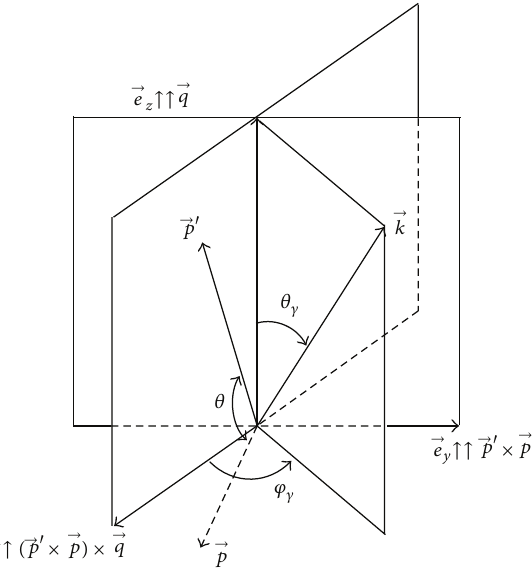
Figure 3: System of